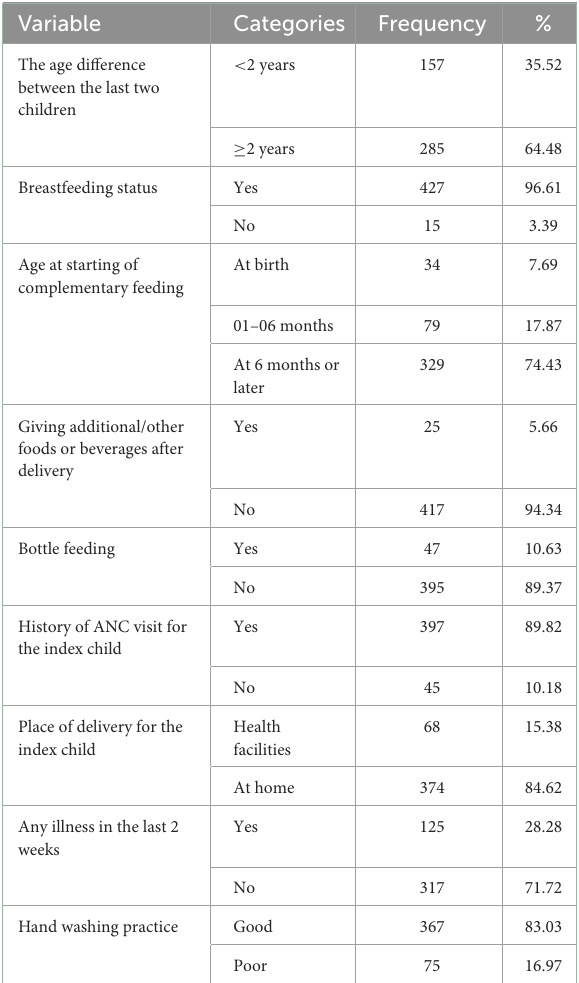
TABLE 2 Obstetrics-related characteristics of the mother for infants aged 6–23 months in South Gondar Zone, Northwest Ethiopia, 2017 ( n = 442).